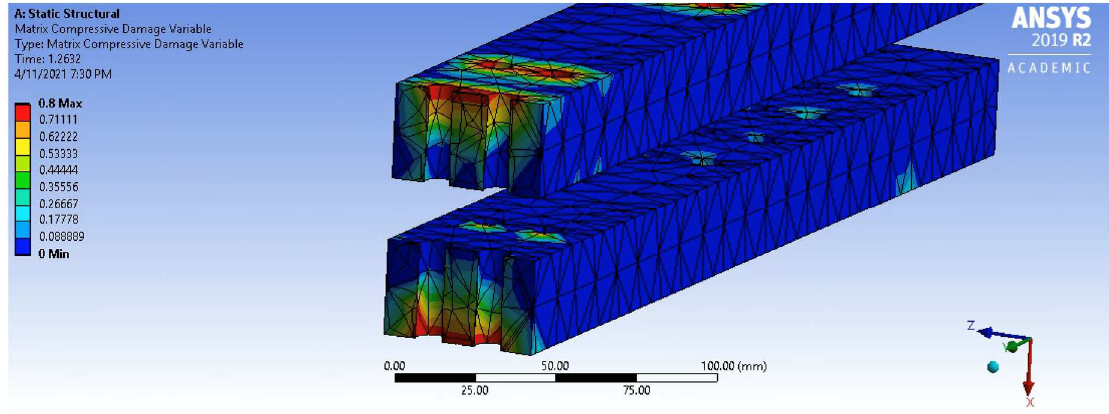
Figure 17. Matrix Compressive Damage at the End of Phase 1. Figure 18. Matrix Compressive Damage at the End of Phase